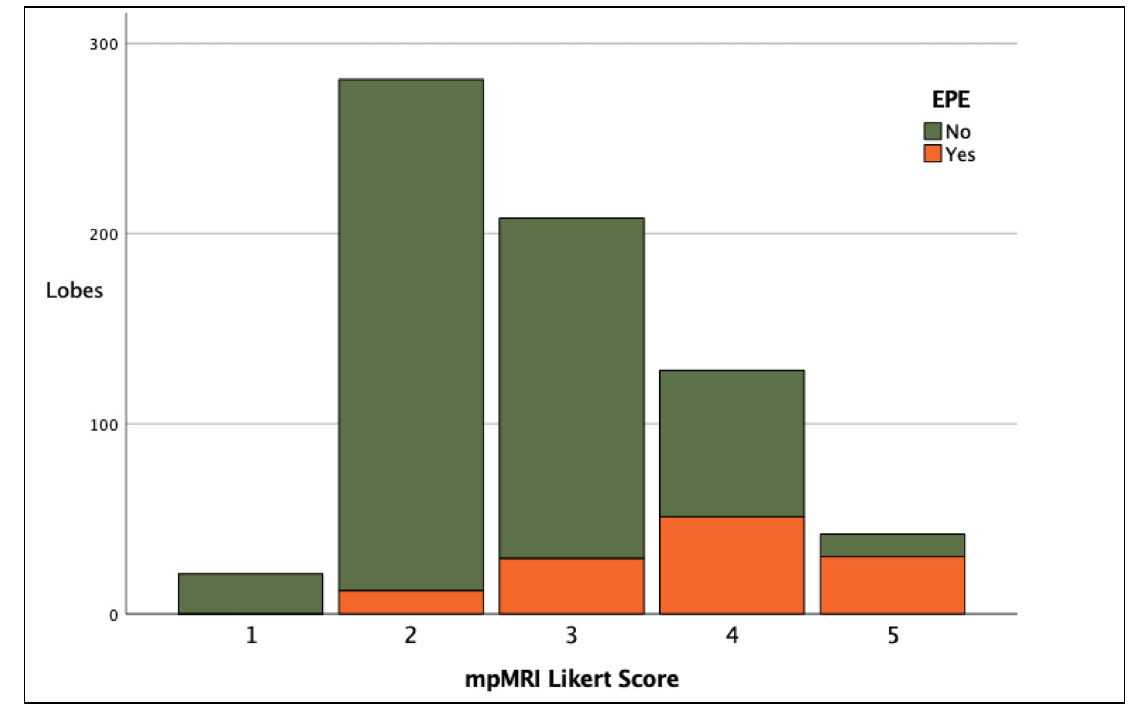
Figure 3. Stacked bar chart showing clinical detection of EPE per lobe according to final Likert score.